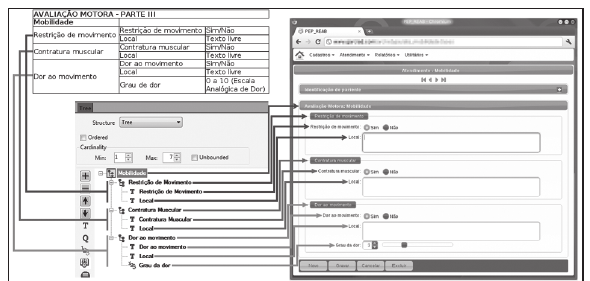
Figura 1 - Interface para o arquétipo "Mobilidade" Fonte: Dados da pesquisa.